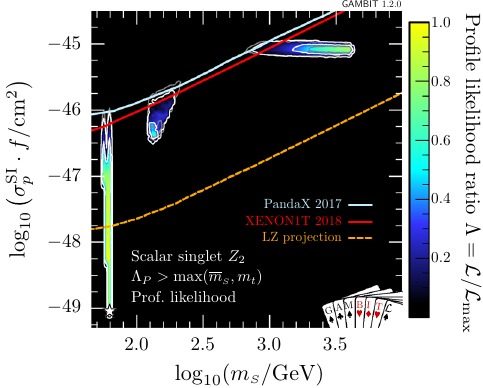
Fig. 3 Profile likelihood for the Z 2 scalar singlet model with the requirement Λ P > max ( m S , m t ) . The preferred regions are expressed as a function of m S and the spin-independent direct detection cross- section for scattering with protons rescaled to the predicted relic abun- dance σ SI p · f , and compared to the exclusion bounds from various direct detection experiments. Contour lines indicate 1 σ and 2 σ con- fidence regions, and best fit points are indicated with stars. Shading and white contours show the result of including the 2018 XENON1T analysis [55], whereas grey annotations illustrate the impact of using the 2017 analysis [54] instead. Coloured solid lines indicate published limits from PandaX [56] and XENON1T [55], and the dashed line is the projected sensitivity of LZ [94]